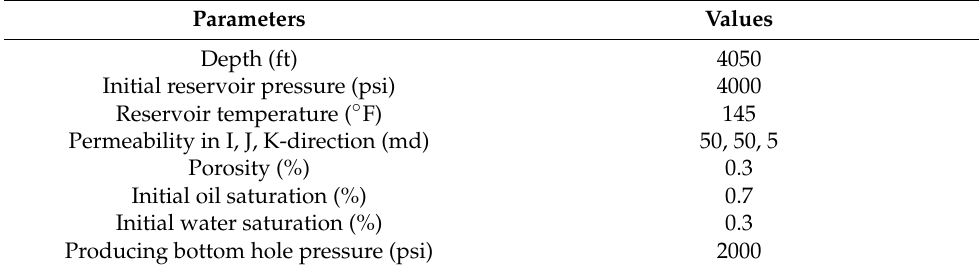
Table 7. Reservoir initial and operating conditions.